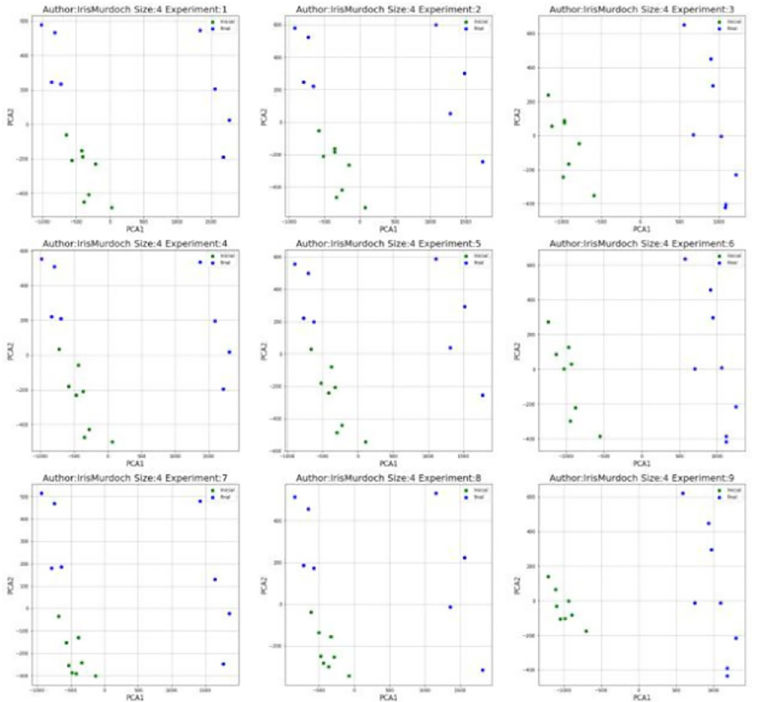
Fig 11. PCA visualization of Iris Murdoch (IM) using syntactic relationship 3-gram.